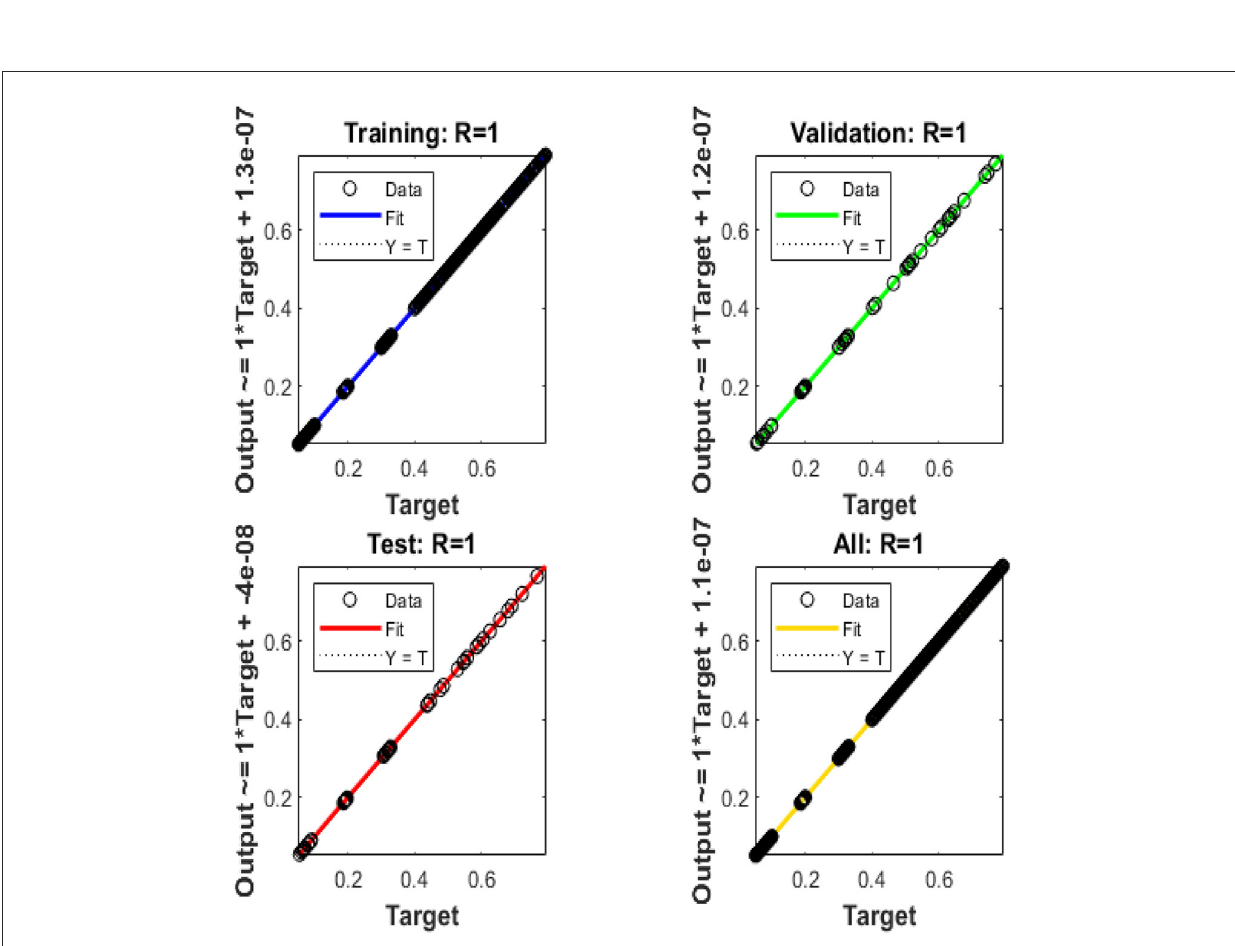
FIGURE4 Regression performances for the HBVNS model: Case